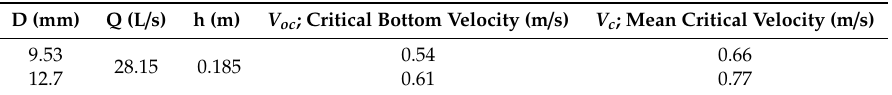
Table 3. Experimental conditions.